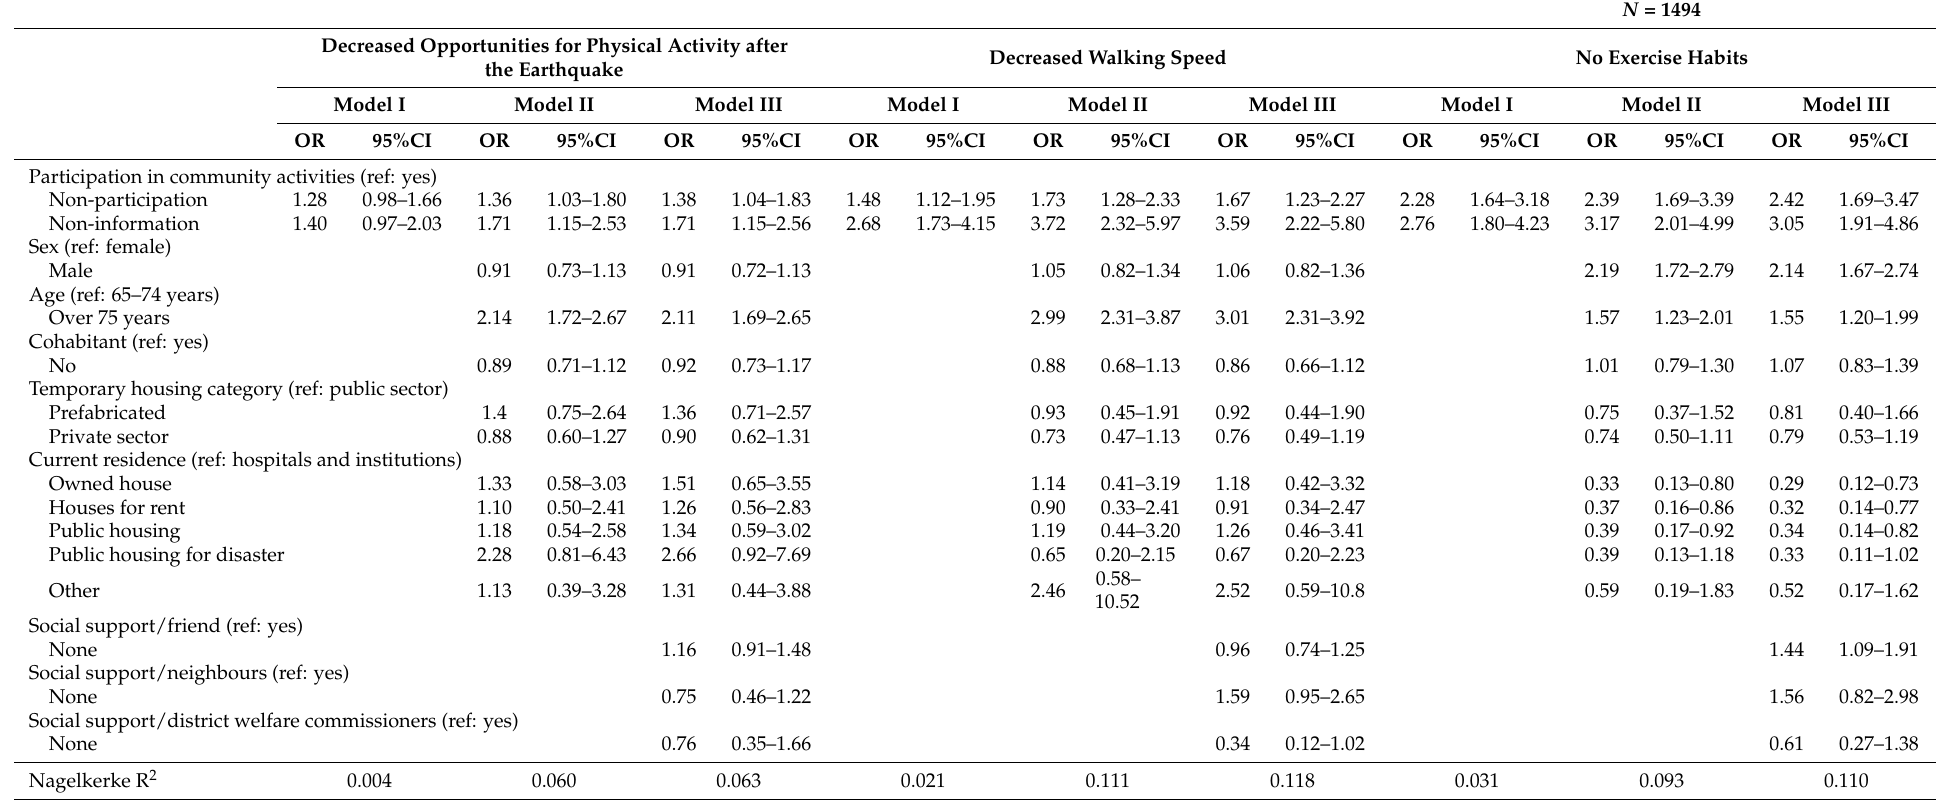
Table 4. Association between physical activity and each independent